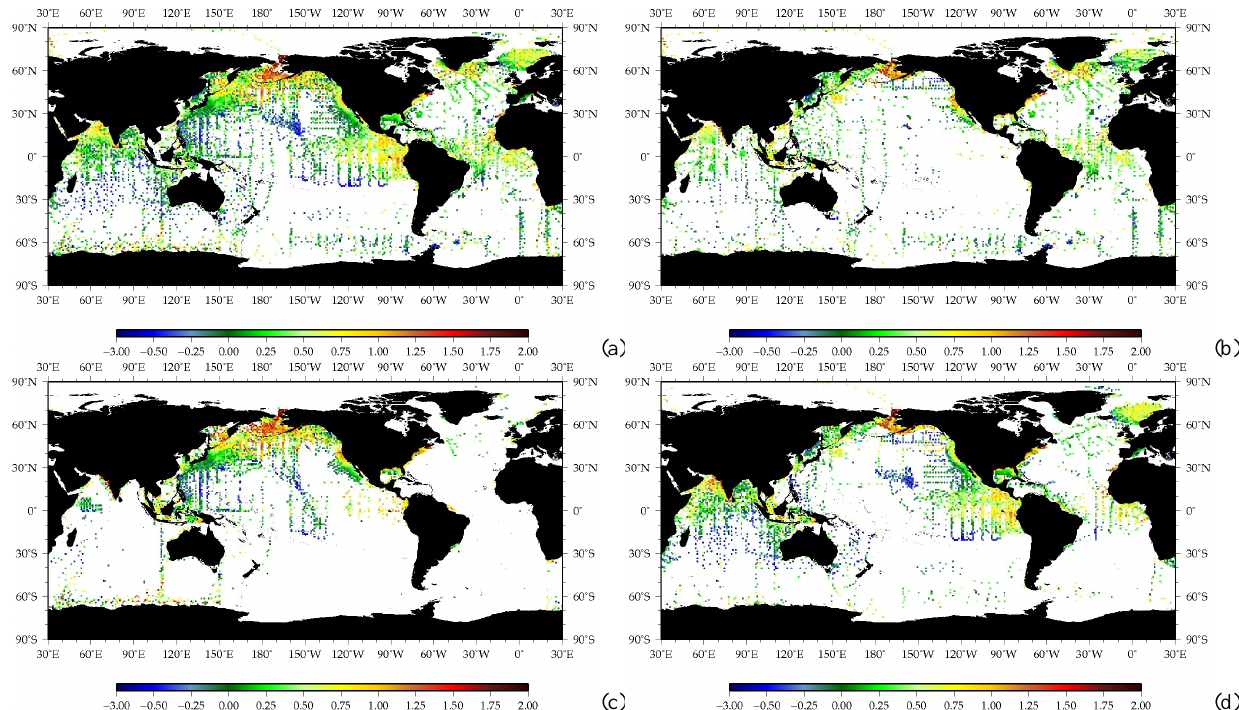
Figure 6. Annual mean mesozooplankton biomass ( µ gCL − 1 ): (a) combined 0–100m, 0–150, and 0–200m sampling depth intervals (zCAT i100 + i150 + i200); (b) 0–100m sampling depth interval (zCAT i100) (c) 0–150m sampling depth interval (zCAT i150) and (d) 0–200m sampling depth interval (zCAT i200). Sampling mesh of ∼ 333 µ m in